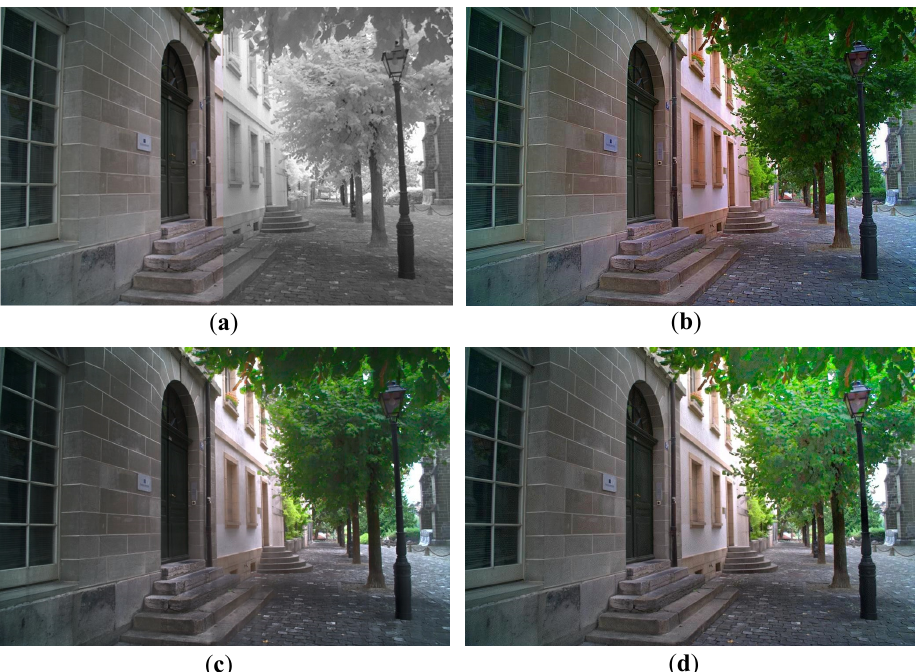
Figure 11. Input image pair and resulting images: ( a ) input VIS and NIR images, ( b ) Laplacian pyramid fusion [1], ( c ) low-rank fusion [5], and ( d ) the proposed method.